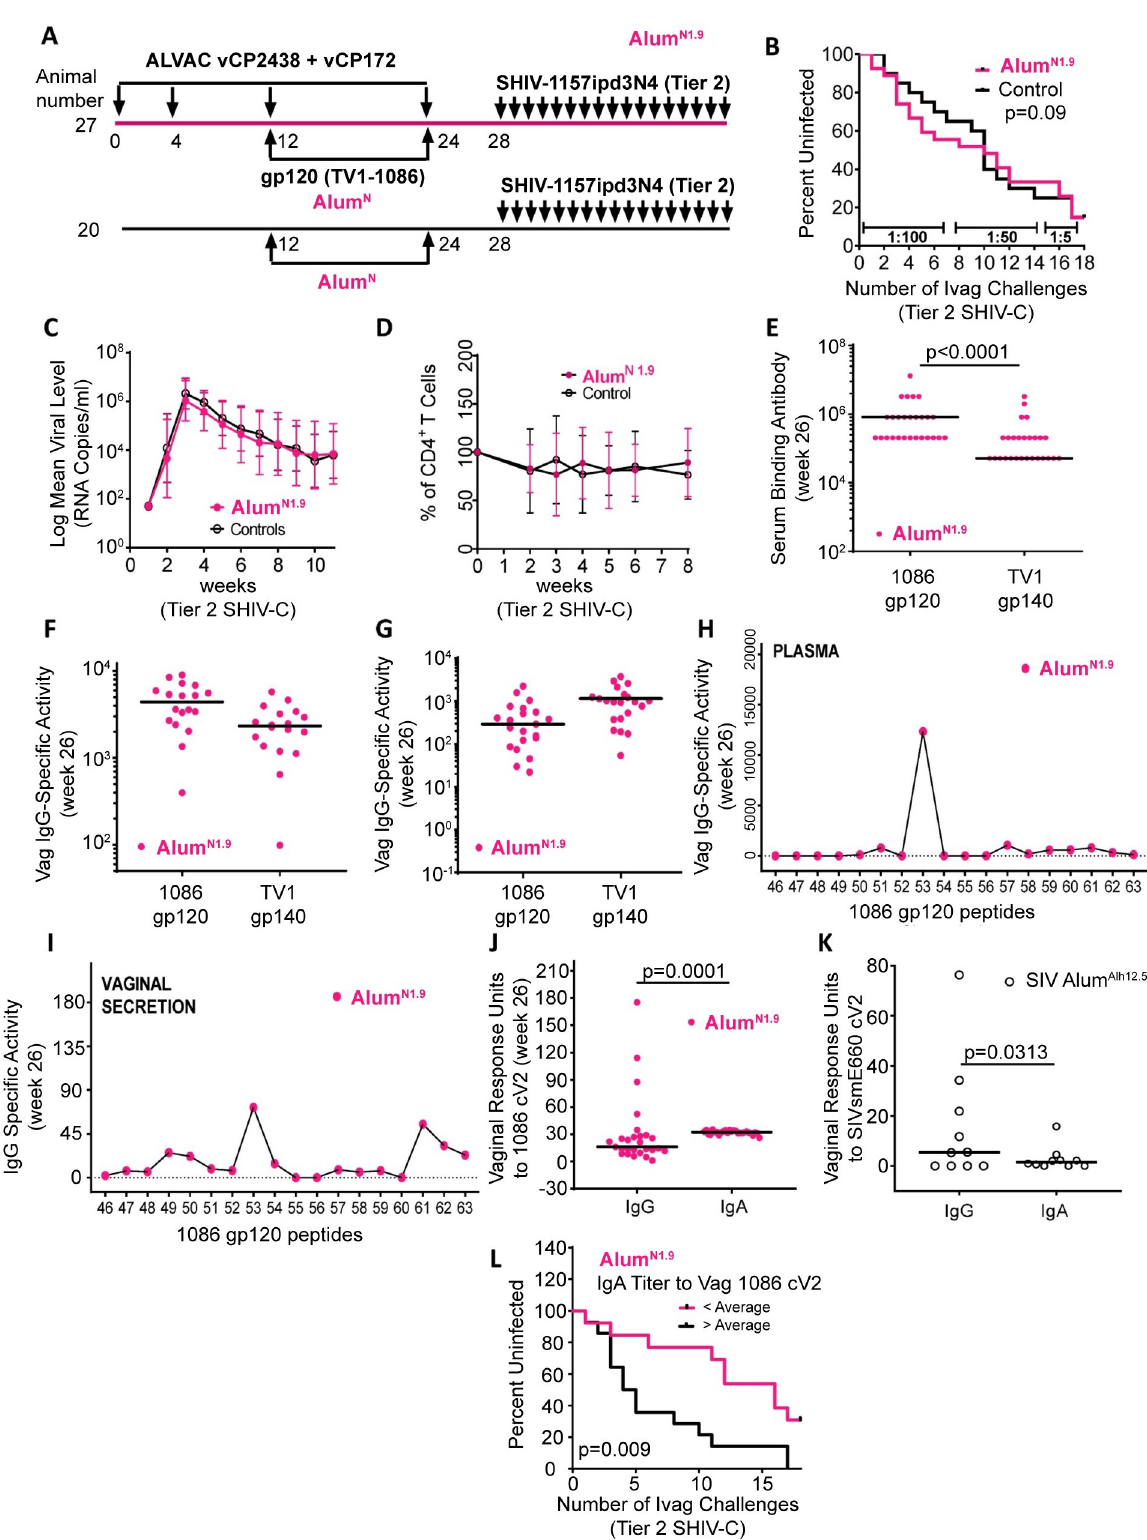
Fig 1. Relative efficacy and immunogenicity of the Alum N1.9 regimen. Unless stated otherwise, all assays, experiments and graphs associated with the Alum N1.9 study are represented by full red circles, and available samples (i.e., those not depleted in other experiments) are shown as